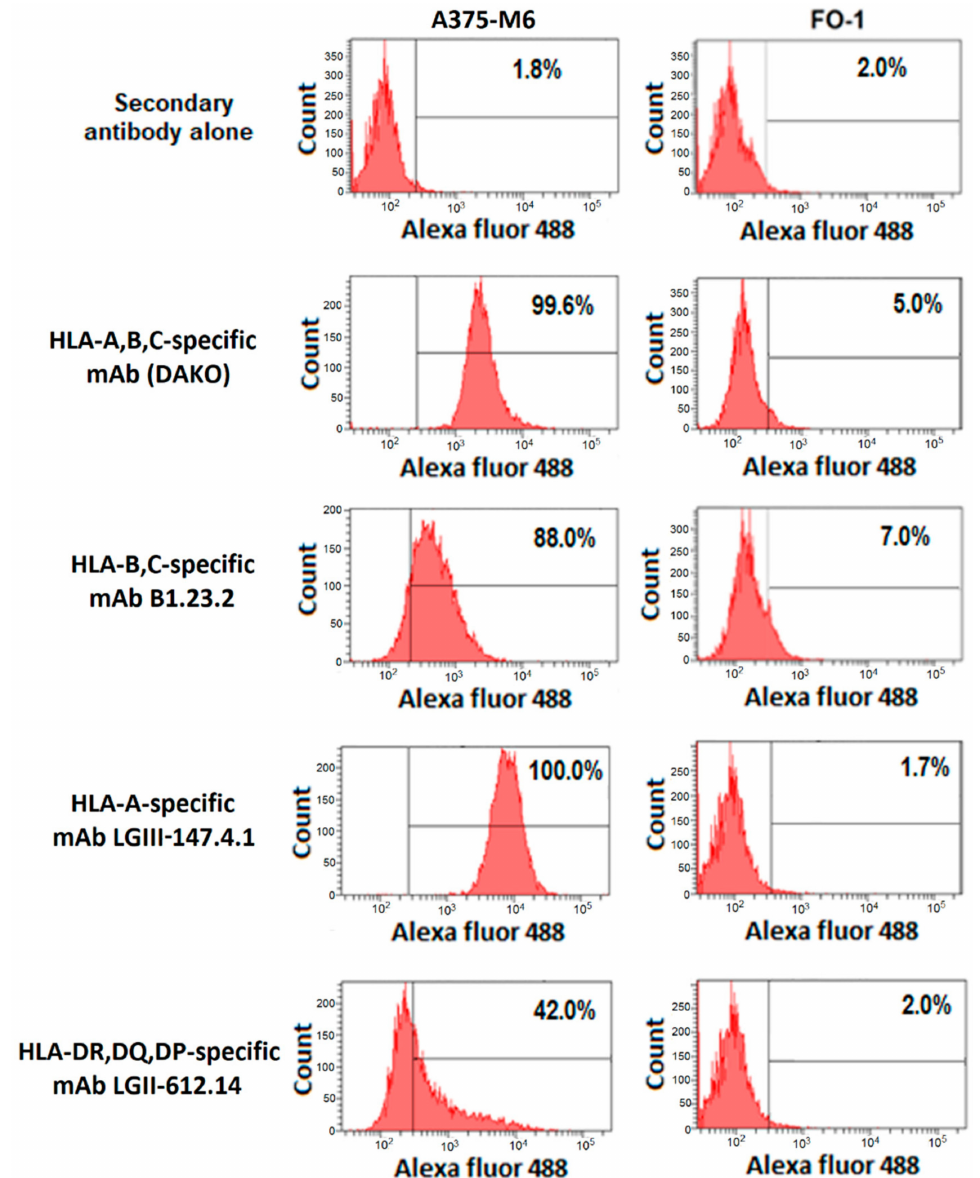
Figure 1. HLA class I and II antigen expression on melanoma cells. A375-M6 (left panel) and FO-1 (right panel) melanoma cells were stained with HLA-specific mAbs and analyzed with a flow cytometer. Numbers indicate the % of stained